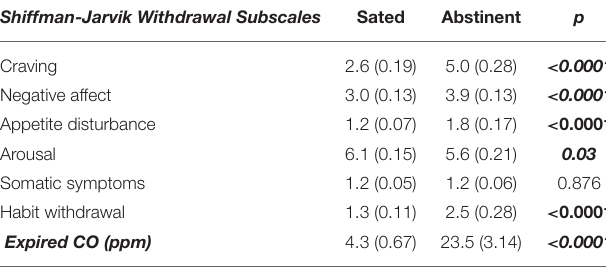
TABLE 2 | State measures: nicotine withdrawal and expired CO.